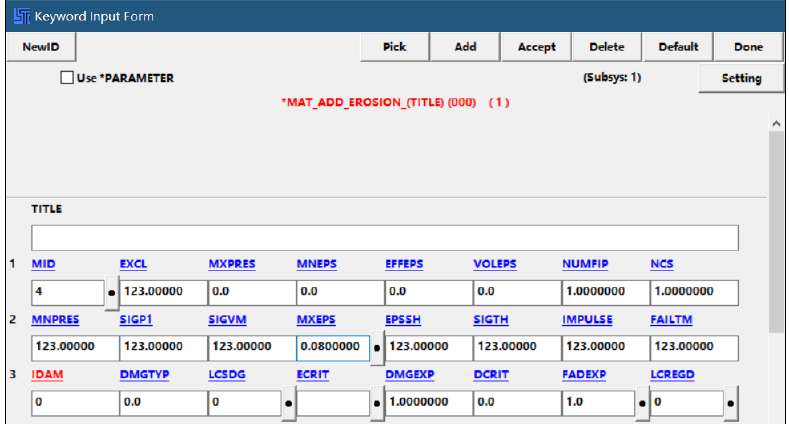
Figure 10. Keyword-MAT_ADD_EROSION.